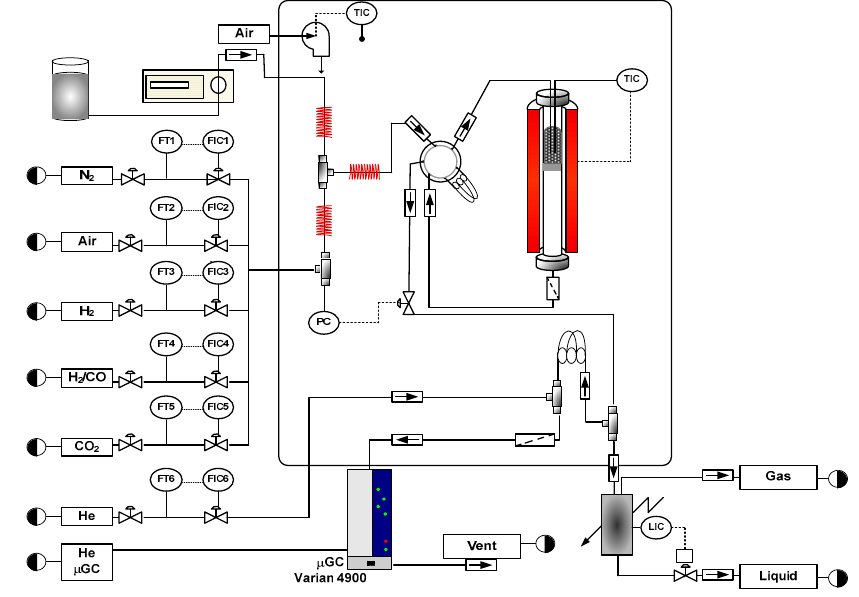
Figure 1. Reaction equipment; FIC: Flow Indicator Controller; TIC: Temperature Indicator Controller; LIC: Level Indicator Controller; PC: Pressure Controller; FT: Flow Transmiter.